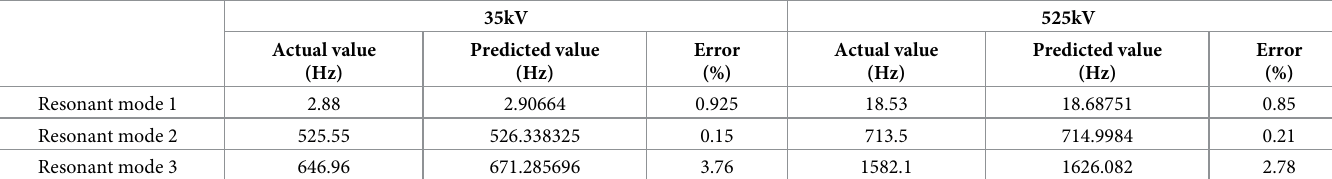
Table 14. Prediction of the resonance